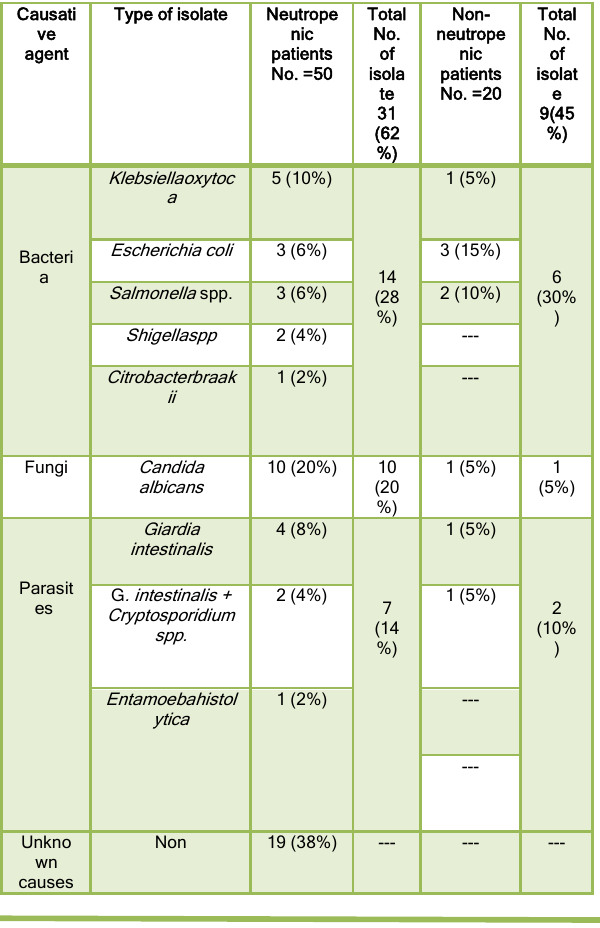
Fig. 1: Types of diarrhea among neutropenic and non- neutropenic groups The difference in the infection rates between study and control groups is statistically non-significant with P > 0.05. Table 1: Microbial evaluation of the stool samples in the neutropenic and non-neutropenic groups